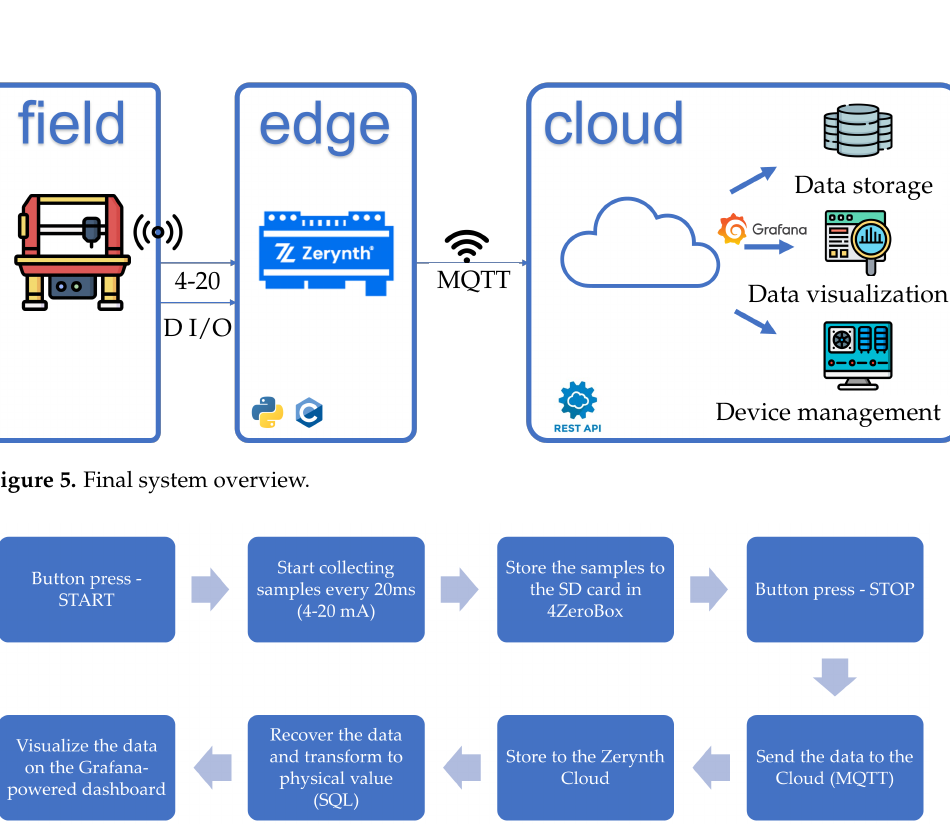
Figure 6. Flowchart of the broaching process digitization solution.